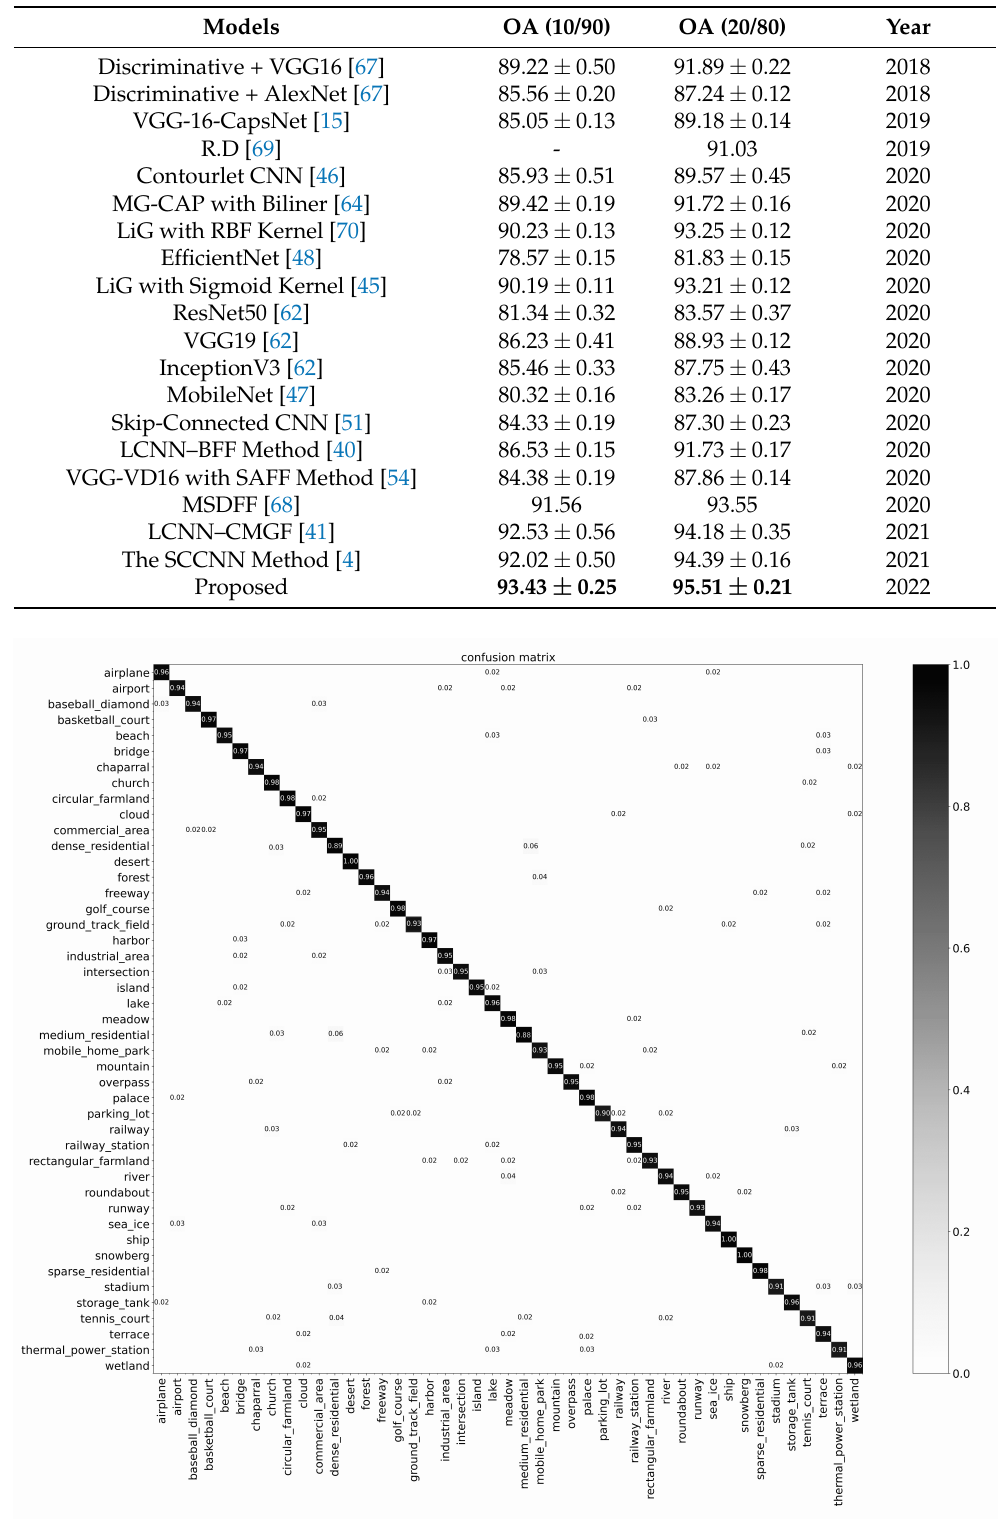
Table 11. OA comparison on NWPU dataset.